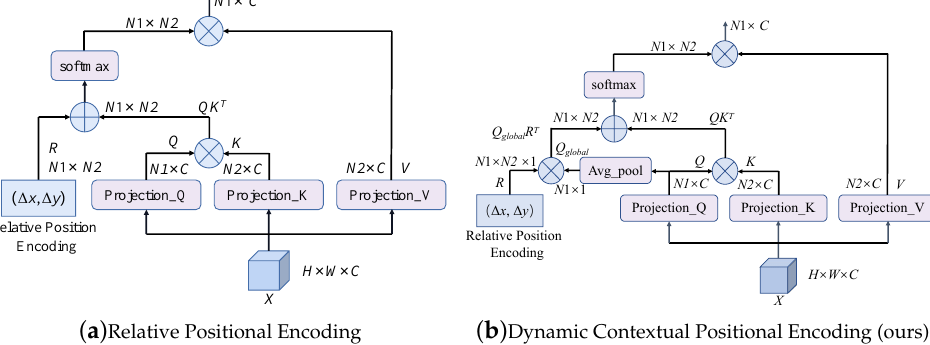
Figure 5. Two different positional encoding mechanisms can be used for our proposed LGViT, as well as other Vision